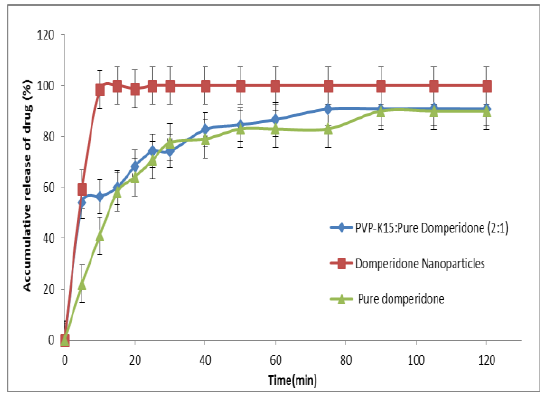
Figure 20. The In-vitro release of the pure domperidone, F8, physical mixture of PVP- K15:pure domperidone (2:1) in 0.1N HCl of pH 1.2 at 50rpm and 37° C (±SEM, n=3).